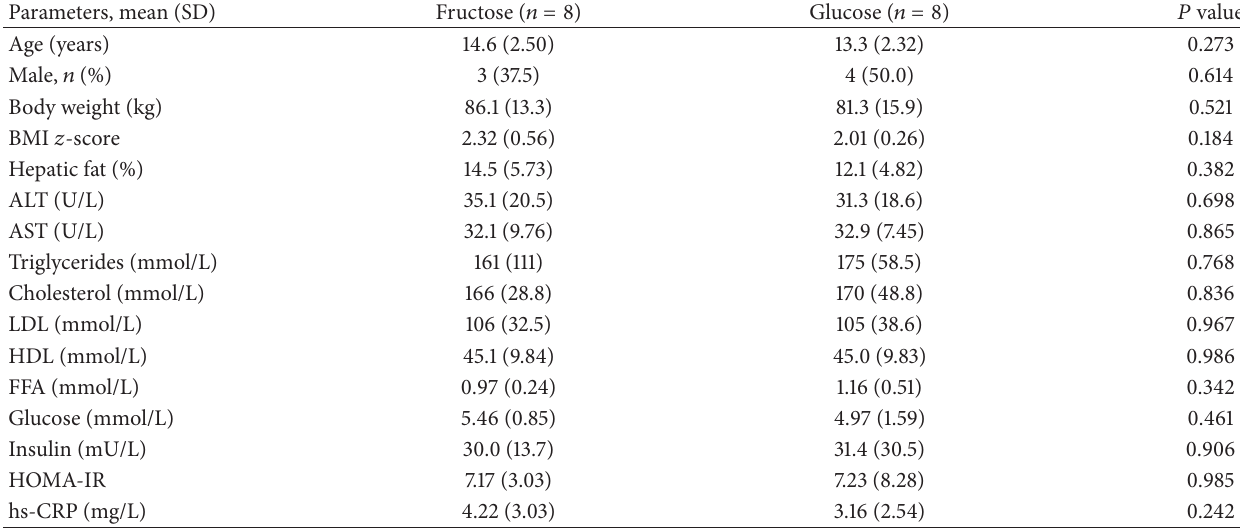
Table 3: Baseline characteristics of participants enrolled in the 4-week beverage trial: study cohort